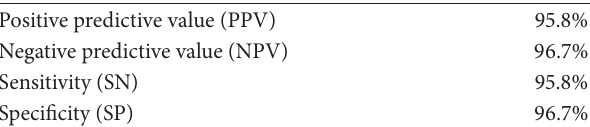
Table 2: Overall accuracy of PET/CT in irradiated neck. Positive predictive value